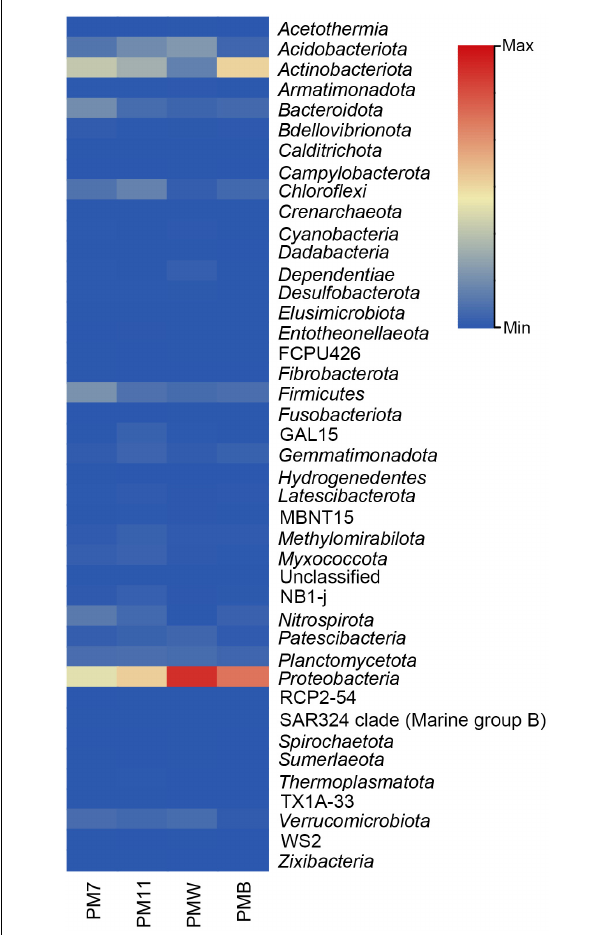
FIGURE 3 | The relative abundance (only > 1% are represented) of the bacterial classes in the four analyzed samples of Muierilor